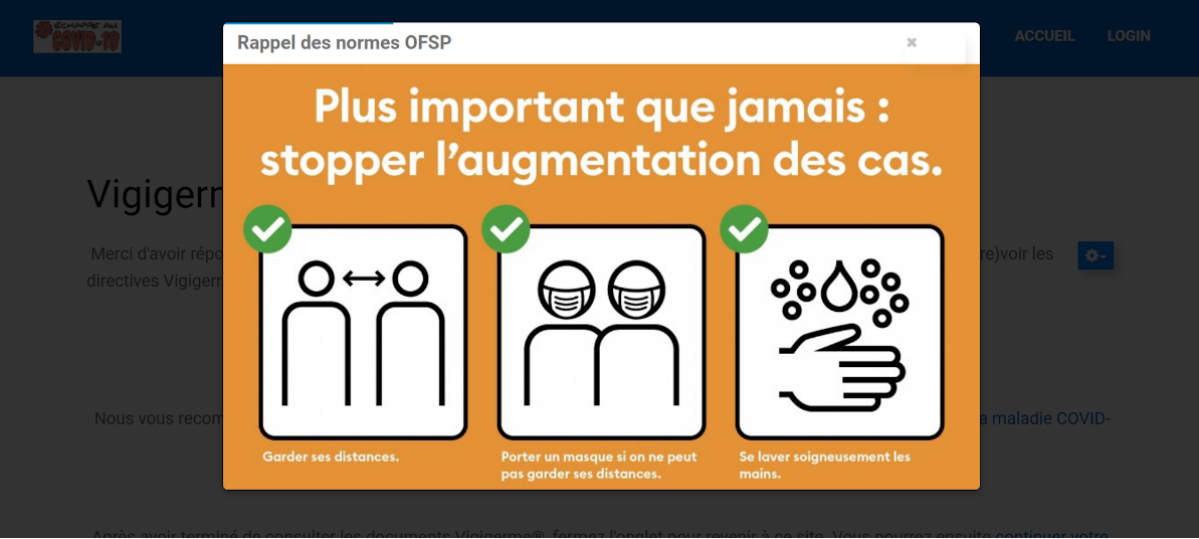
Figure 5. Control material (in French). The model was displayed for 10 seconds before providing links to infection prevention and control guidelines.